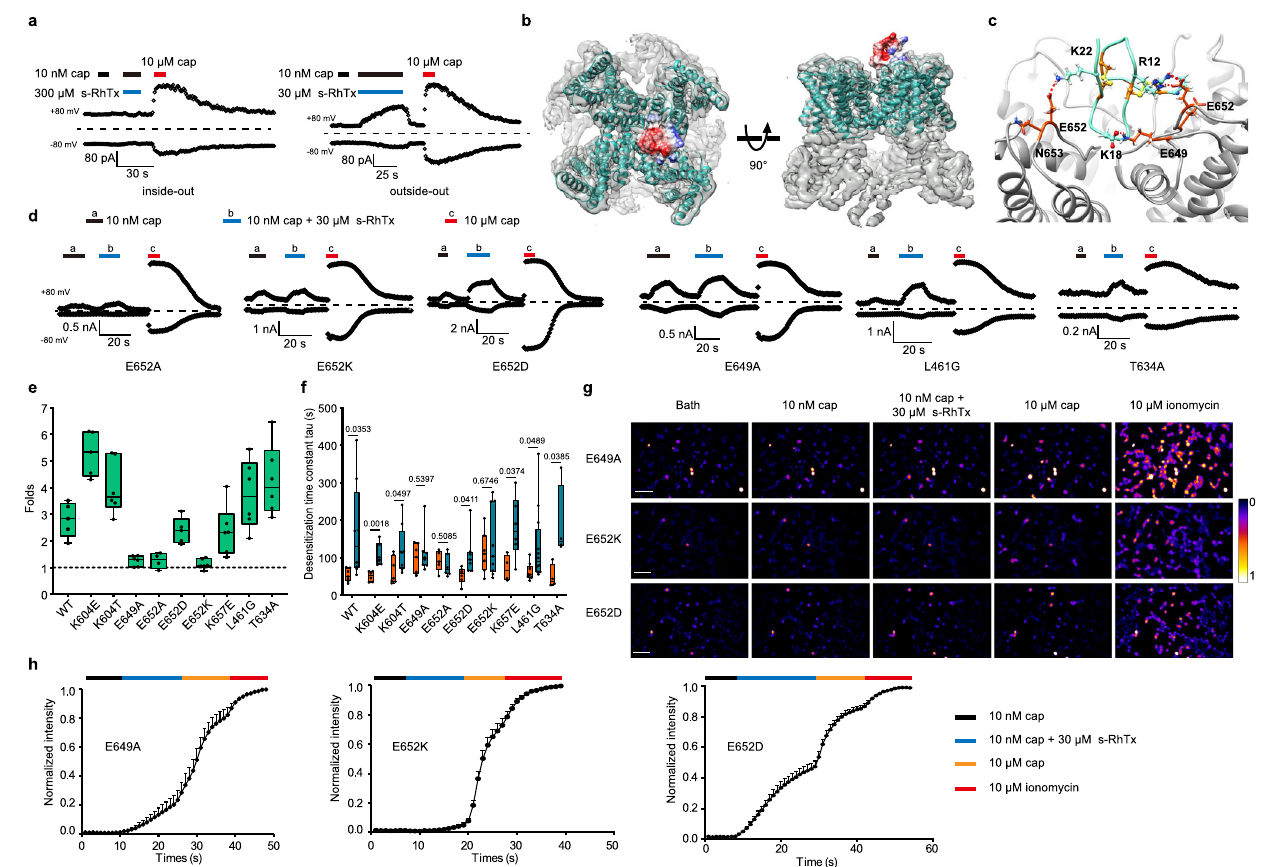
n =4 for E652A; n =6 for K604T, E649A, E652K, K657E, L461G, T634A). f Summary of desensitization time constant of TRPV1 point mutants (Data in box and whisker plot was given from the minima to maxima, the bounds of box represent the 25th percentile and 75th percentile and the middle line of box is the median. Data were representedasmean±S.E.M.frombiologicallyindependentcells;For10 μ Mcap, n =7forWT,K604T,E649A,E652K; n =4forK657E,T634A; n =5forE652Aand n =6 forK604E,E652D;For10 μ Mcap+30 μ Ms-RhTx, n =8forWT,K604T,E649A; n =4 forT634A; n =6forK604E,E652A,K657E; n =7forE652Dand n =12forL461G.Two- sided t-test, the exact P values were labeled in the panels). g Calcium imaging in HEK293T cells expressing E649A, E652K, and E652D mutants responded to 10nM capsaicin, the cocktail of 10nM capsaicin and 30 μ M s-RhTx, 10 μ M capsaicin, and 10 μ M ionomycin, respectively, scale bar = 100 μ m; h the normalized fl uorescence intensity of calcium images of TRPV1 E649A, E652K, and E652D mutants (mean± S.E.M. from biologically independent cells; n =13 for E649A, n =16 for E652K and n =45 for E652D). Source data are available as a Source Data fi